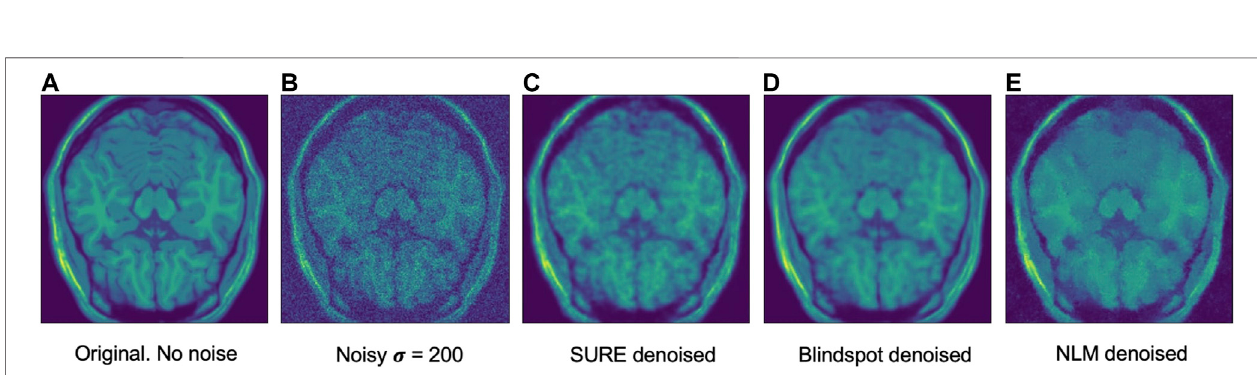
FIGURE 8 | Example of denoised brain MRI for σ (cid:1) 100. The example image is the middle slice from one of the subjects. In this case, this is the PSNR for every methodforthisparticular subject. (A) Originalimage, nonoiseadded — (B) Noisyimage — (C) SUREPSNR (cid:1) 38.130 — (D) BlindspotPSNR (cid:1) 39.072 — (E) NLMPSNR (cid:1) 37.108.